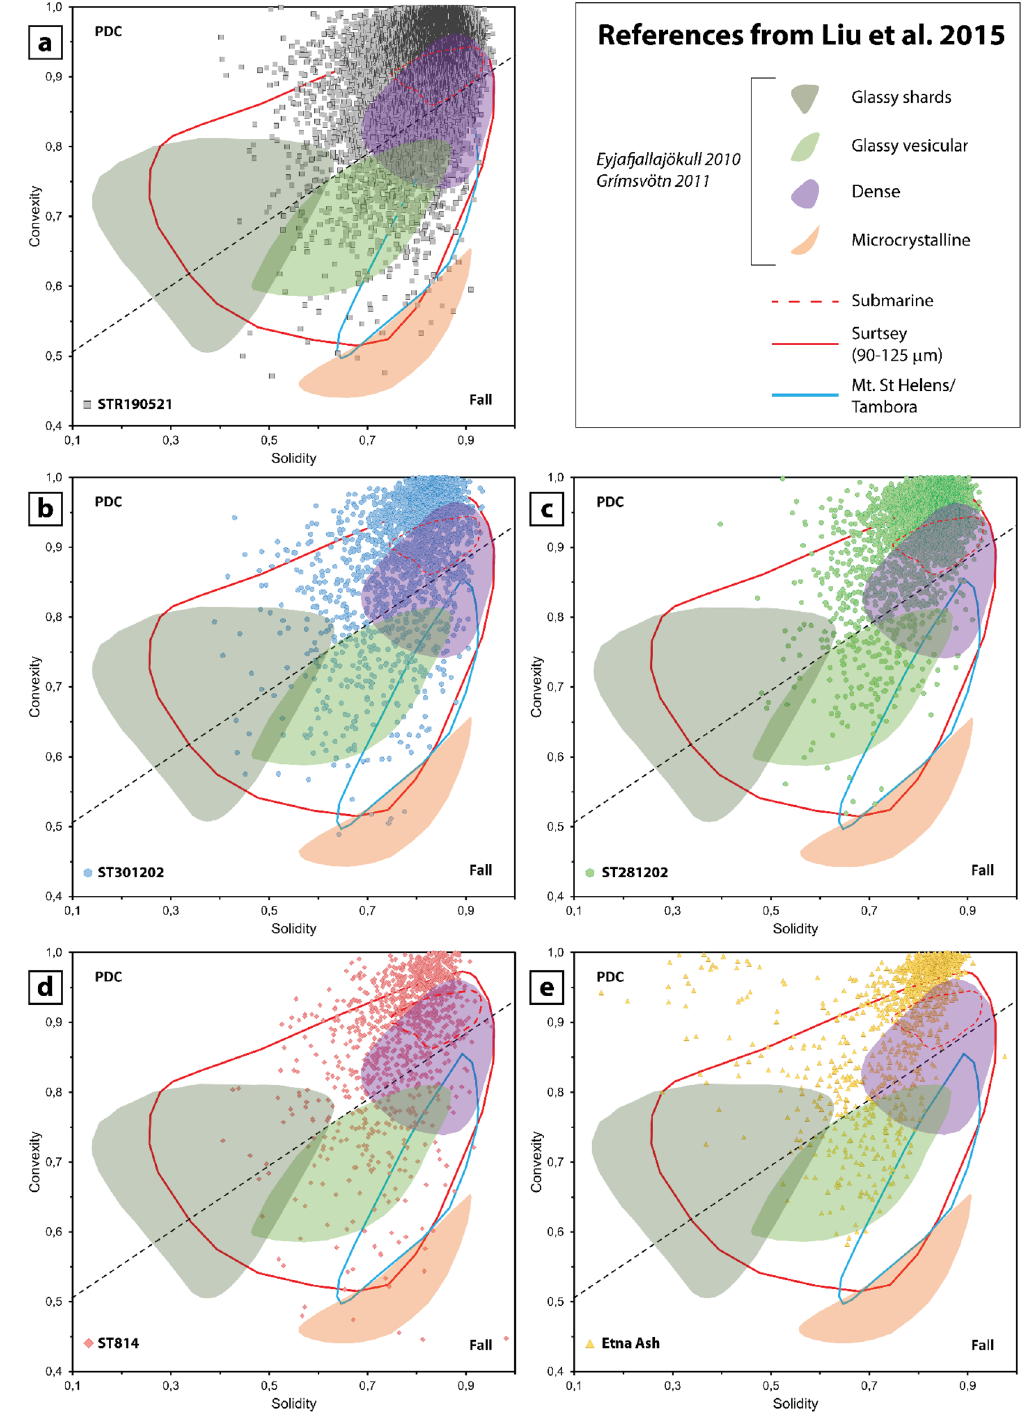
Figure 9. Solidity versus convexity plots (after 29 ). The black dashed line marked the threshold between flow (PDC) deposits and fallout. Each plot shows one individual sample, and the fields of some literature samples, reported in the legend, are